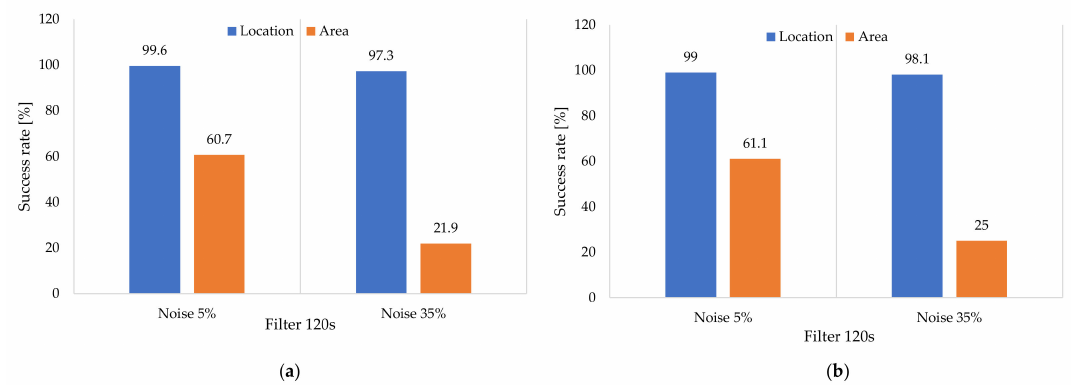
Figure 14. The success rate of calculating the correct breach. ( a ) All doors closed and ( b ) fireproof doors open (redrawn based on data in Penttilä and Ruponen